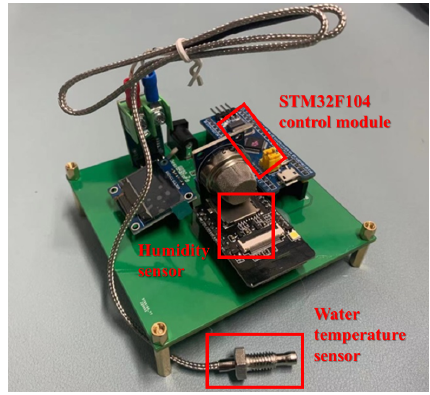
Figure 10. Hydrological sensor experiment